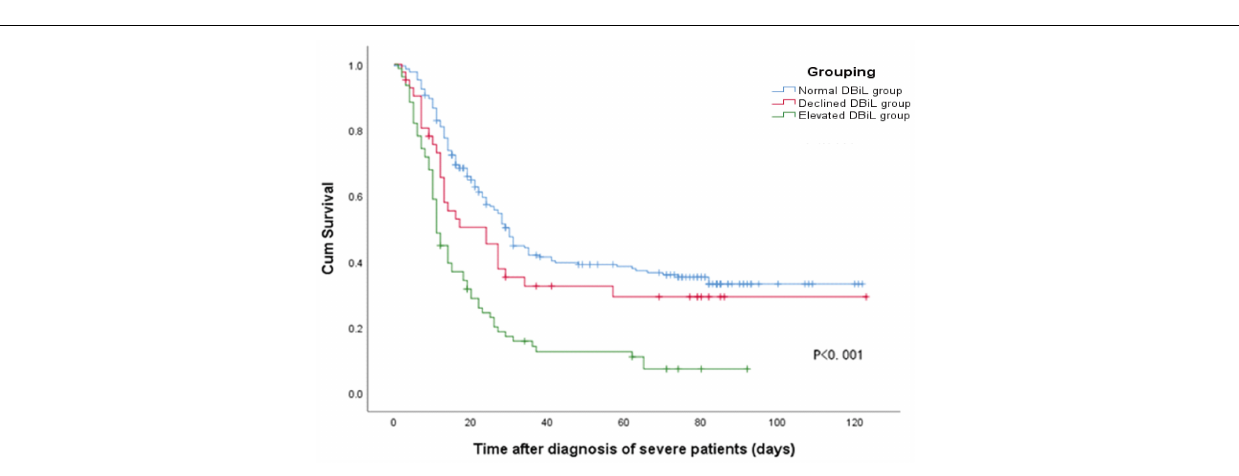
FIGURE 2 | Kaplan-Meier curve shows the cumulative survival rate of 337 COVID-19 patients in different DBiL groups after being diagnosed as severely/critically ill